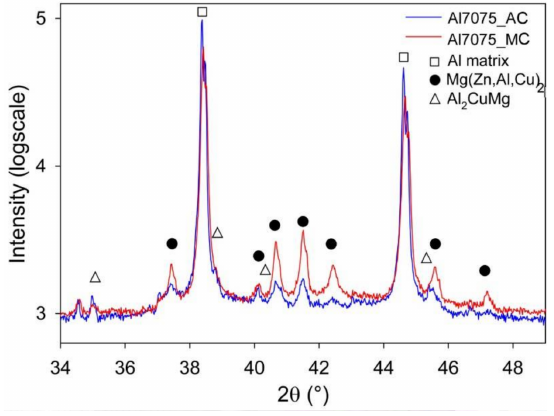
Figure 9. The XRD patterns of the Al7075_AC and Al7075_MC